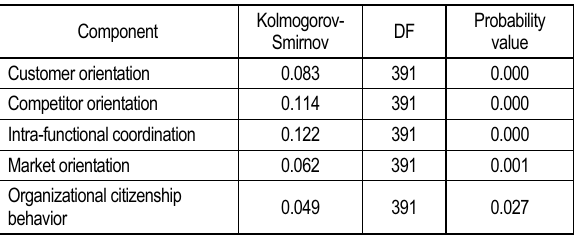
Table 2. Results of Kolmogorov-Smirnov test to for normal distribution of data